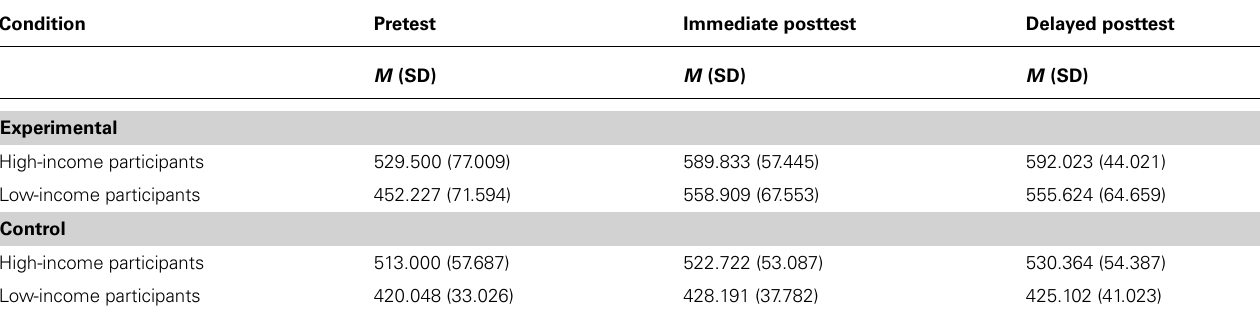
Table 1 | Mean selective visual attention pretest, immediate posttest, and delayed posttest scores for high- and low-income participants in the control and experimental conditions.